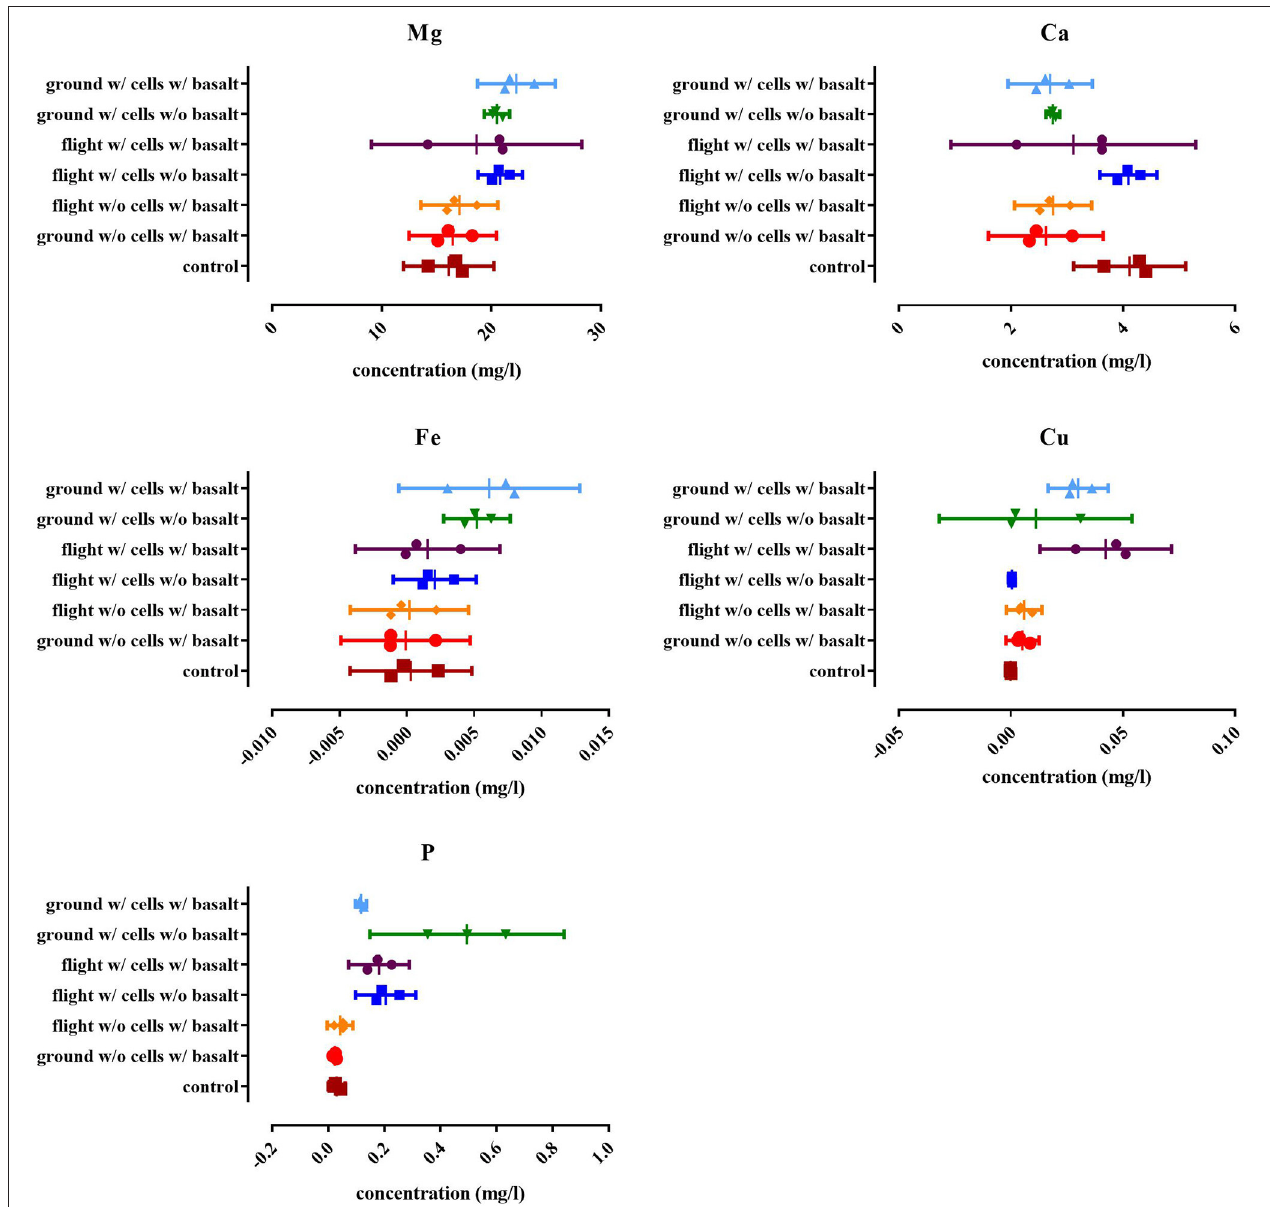
FIGURE 5 | Results of the ICP-OES analysis for the magnesium (Mg), total phosphate (P), calcium (Ca), iron (Fe), and copper (Cu) content expressed as the concentration in the suspension (in mg/l). The “control” is the concentration of the respective elements in the water used at the start of the experiment. All replicates are represented by a dot, the mean is indicated as well as the 95% confidence interval. For the statistical analysis, one way ANOVA was used with Tukey post testing (alpha = 0.05), p -values as well as significance are reported in Supplementary Table S2